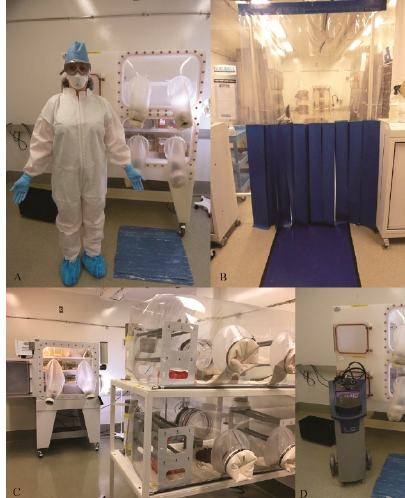
Figure 1. Equipment of the sterile environment (Bio-Bubble). ( a ) Personal Protective Equipment (PPE) required while using the Bio-Bubble: disposable coveralls, double shoe covers, double gloves, mask, double hair covers, goggles. ( b ) Antechamber dedicated to decontamination: sterile curtains separating antechamber and sterile room containing isolators and hood. ( c ) Sterile semirigid isolator, SRI, and flexible isolator. On the left of the SRI, port of entry, with sterile chamber for introduction of supplies. ( d ) Fogger (Quip) used to spray decontaminant inside the isolators and in the room prior to